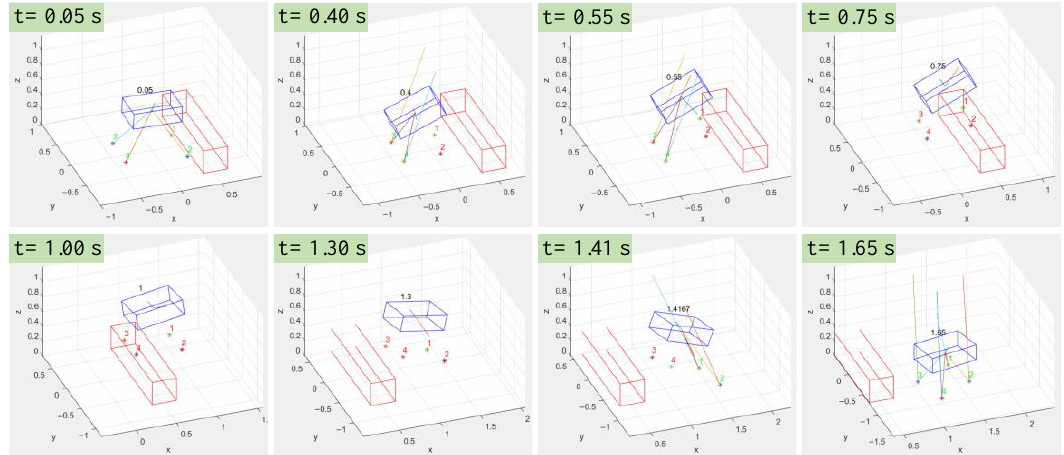
Figure 9. Snapshots of the quadruped robot jumping motion.